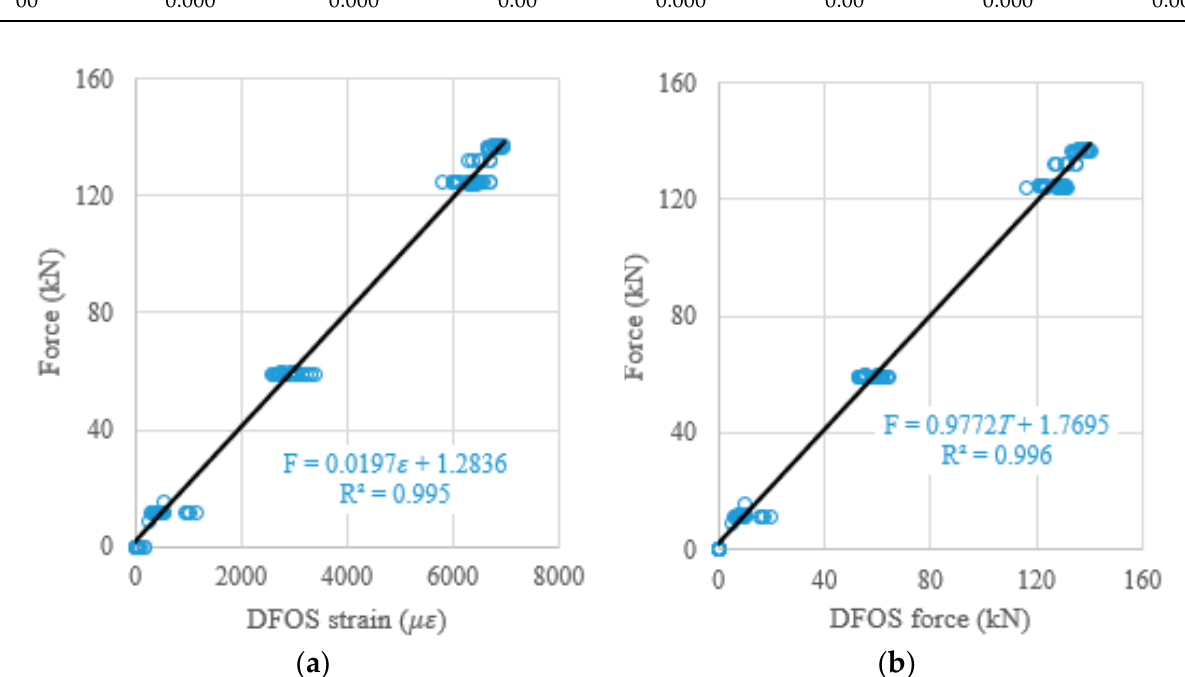
Figure 15. ( a ) Prestressing force versus DFOS average strain; and ( b ) prestressing force versus DFOS average strain-calculated force.